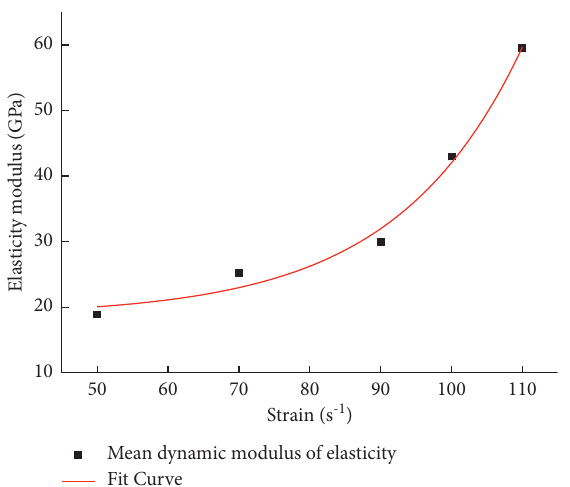
Figure 8: Curve of dynamic elastic modulus with strain rate for marble.